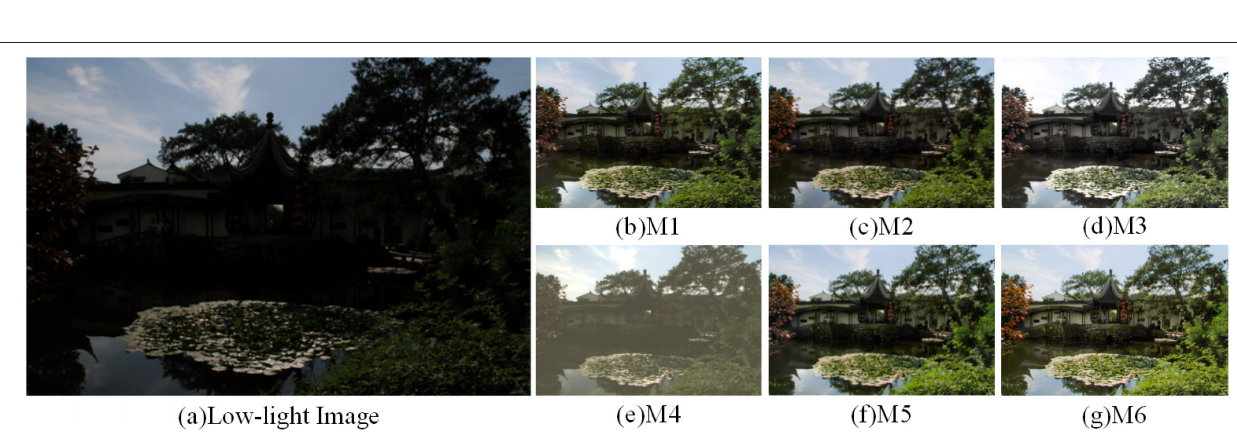
FIGURE 15 | Visual comparison results with different combinations of modules in the MEF dataset. (A) shows the low light image and (B–G) show the effect of the enhanced low light image with different combinations of modules.